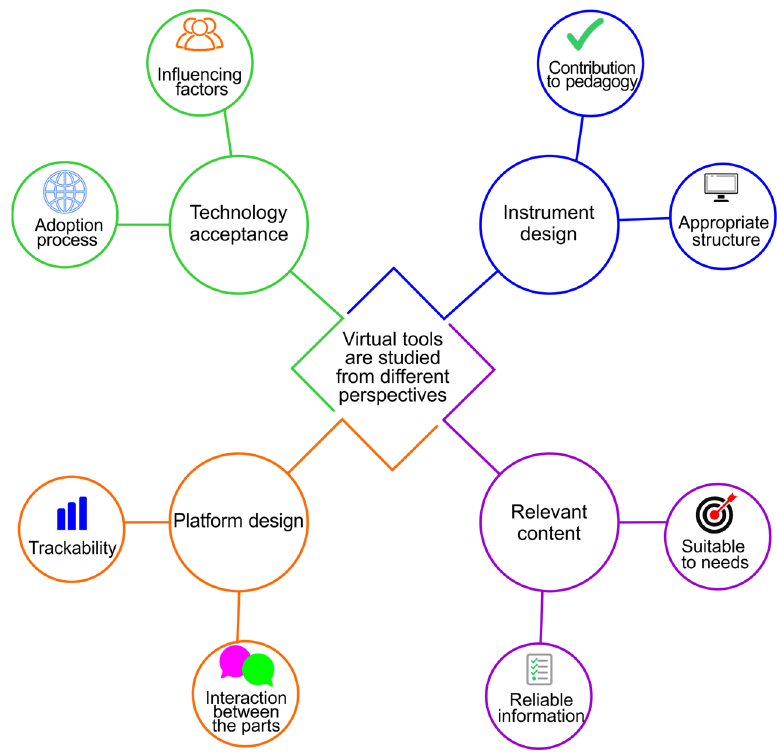
Figure 9. Categories of study for virtual tools. Own elaboration.